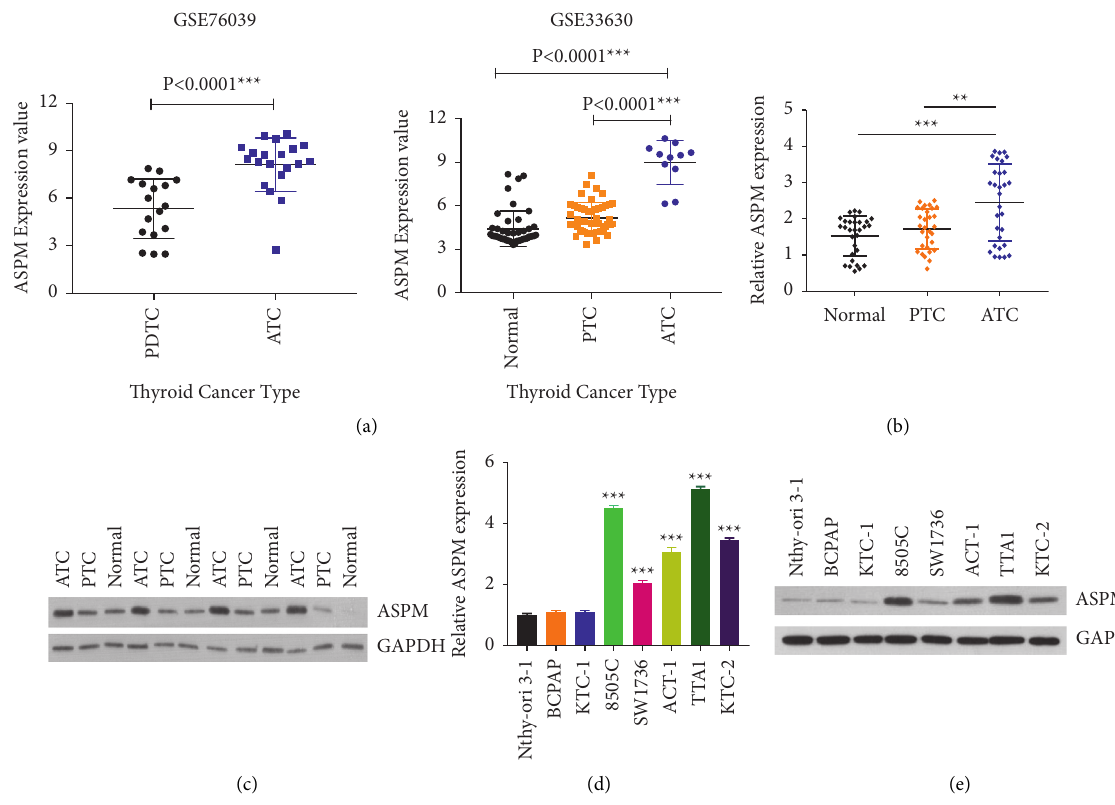
Figure 1: ASPM is upregulated in ATC patients and cell lines. (a) The expression of ASPM in ATC patients based on the data extracted from data sets GSE76039 and GSE33630. (b) The mRNA levels of ASPM in ATC (anaplastic thyroid cancer), PTC (papillary thyroid cancer), and normal thyroid tissues from enrolled patients. (c) The protein levels of ASPM in ATC, PTC, and normal thyroid tissues from enrolled patients. (d) The mRNA levels of ASPM in ATC cell lines. (e) The protein levels of ASPM in ATC cell lines. ∗∗ P < 0 . 01, ∗∗∗ P < 0 .